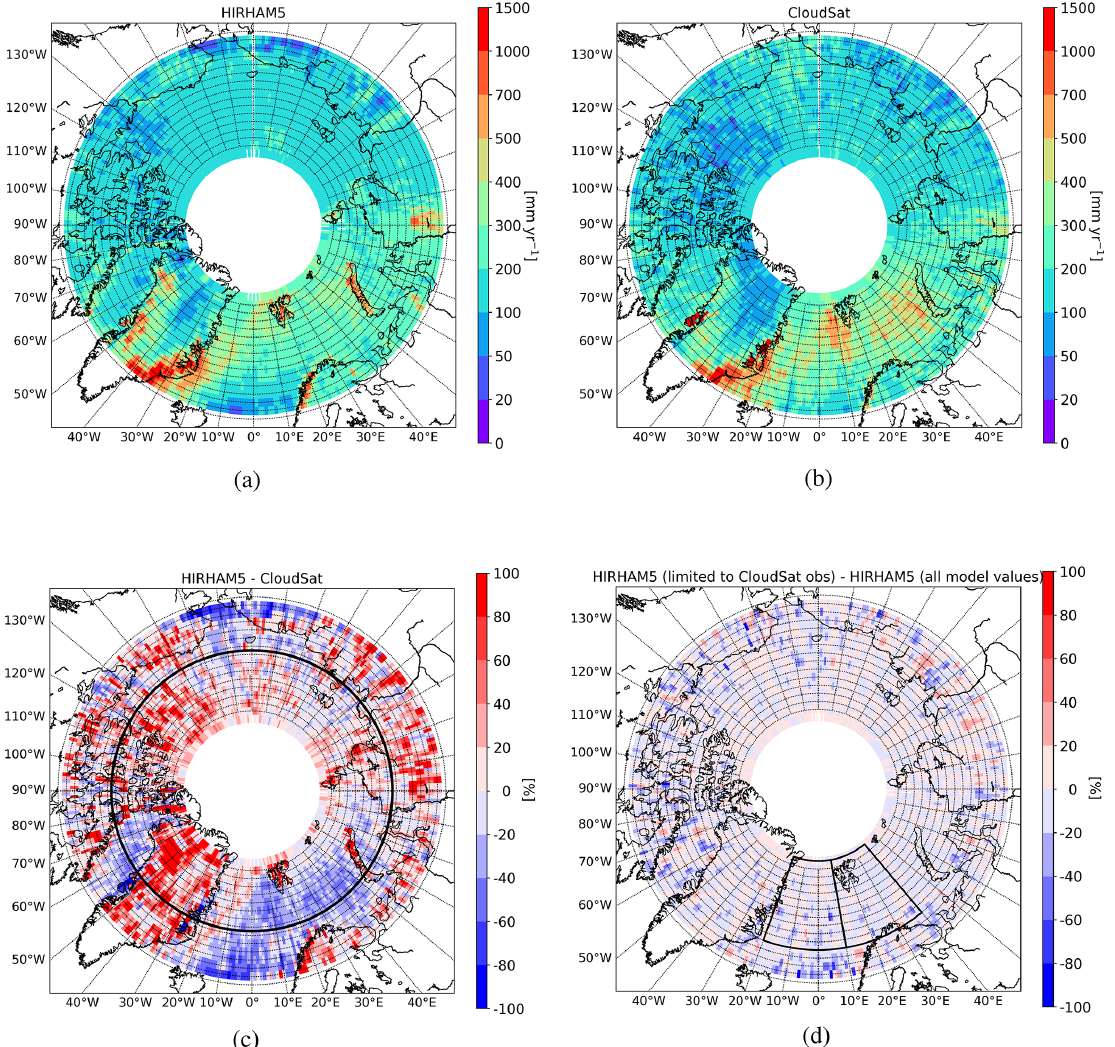
Figure 3. Annual mean snowfall rates during 2007–2010, (a) modeled with HIRHAM5 when periods of CloudSat overpasses are considered and (b) observed with CloudSat and retrieved with the 2C-SNOW-PROFILE product, (c) the difference of snowfall rates between HIRHAM5 and CloudSat, and (d) the difference of the modeled snowfall rates with HIRHAM5, with and without considering the times of CloudSat overpasses. In panel (c) is the difference plot: the red colors show that HIRHAM5 has higher rates, whereas blue colors indicate that CloudSat provides higher rates. Percentages are calculated related to CloudSat observations. The thicker black line in (c) shows the latitude band of 72–73 ◦ N. In panel (d) is the difference plot: the red colors indicate that considering the times of CloudSat overpasses when calculating the mean shows higher rates and blue colors that, when using all daily modeled values, the mean is higher. Percentages are calculated related to model-only values. The sections marked in panel (d) show the two sub-regions in the northern North Atlantic for the CWT analysis (Sect.